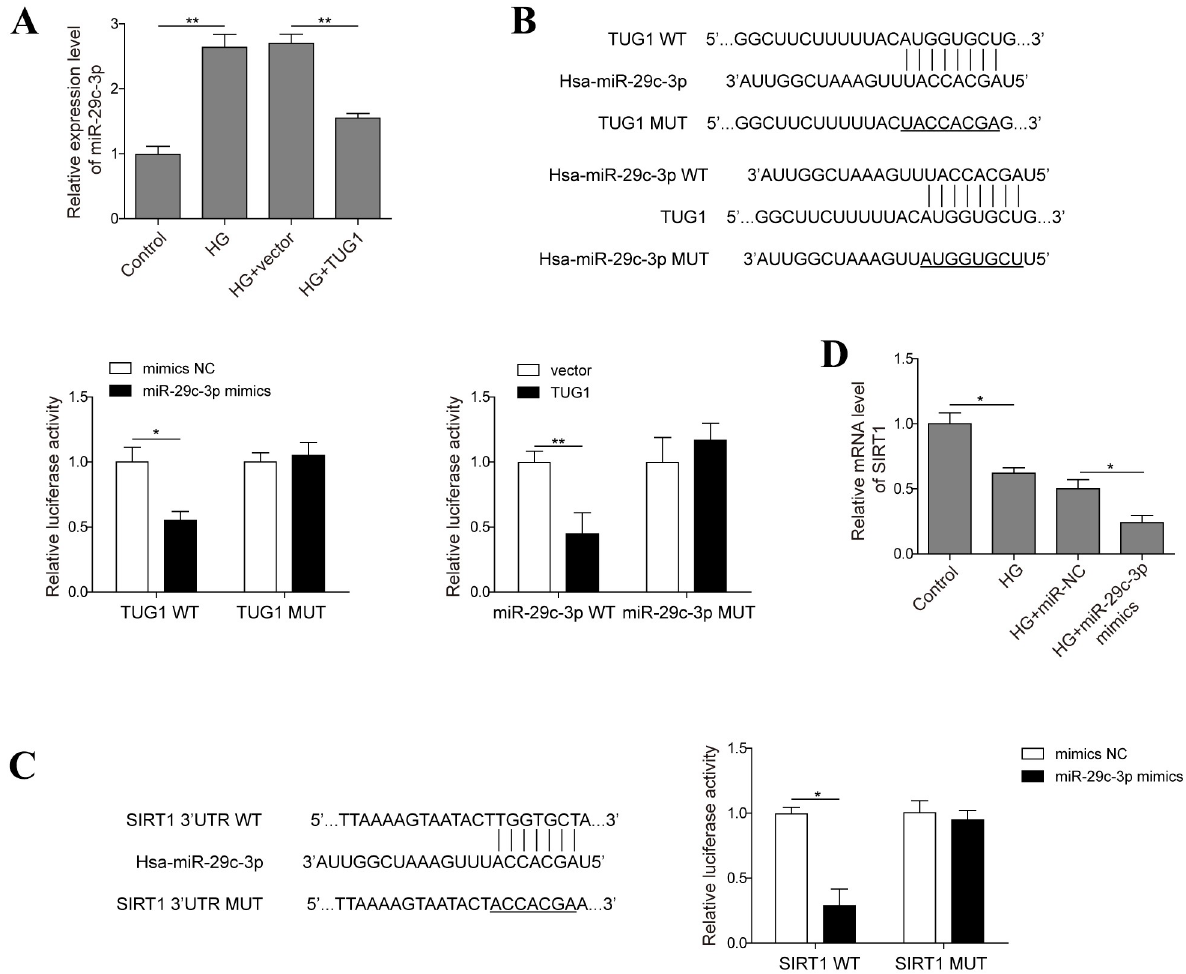
Fig 3. TUG1 interacts with miR-29c-3p which suppresses SIRT1 expression in HK-2 cells. (A) HK-2 cells transfected with empty vector or TUG1 overexpression vector were challenged with 30 mM D-glucose for 48 h, mRNA level of miR-29c-3p was evaluated by real-time PCR. (B) Sequence alignment of TUG1 and miR-29c-3p; HK-2 cells were transfected with miR-29c-3p mimics or TUG1 and wild-type/mutant TUG1 or miR-29c-3p respectively, the luciferase activity was examined. (C) Sequence alignment of miR-29c-3p and 3’-UTR region of SIRT1; HK-2 cells were transfected with miR-29c-3p mimics and plasmid carrying wild-type or mutant SIRT1 3’-UTR, the luciferase activity was examined. (D) HK-2 cells were transfected with miR-29c-3p mimics or mimics NC followed by HG incubation, the expression of SIRT1 was evaluated by real-time PCR. Data were mean ± SD and were representative of three independent experiments. � p < 0.05, �� p <